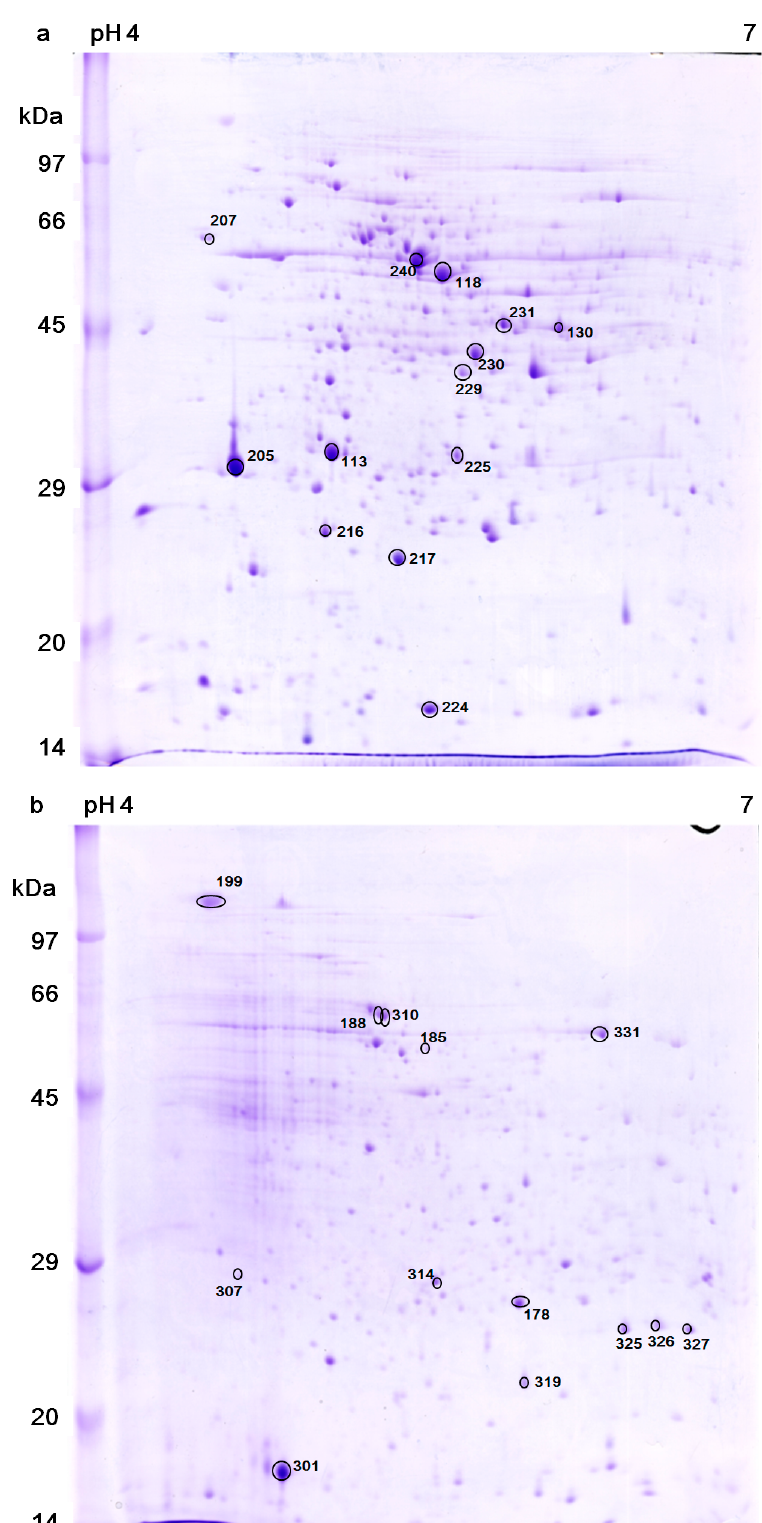
Figure 3. Two dimensional gel electrophoresis (2DE) analysis of the total protein extracts. ( a ) Freshly harvested (control) cells and ( b ) the bleached cells that had been heat-treated (46.5 °C for 1 h) and then cultured under illumination for 24 h. Identified protein spots were marked with numbers.